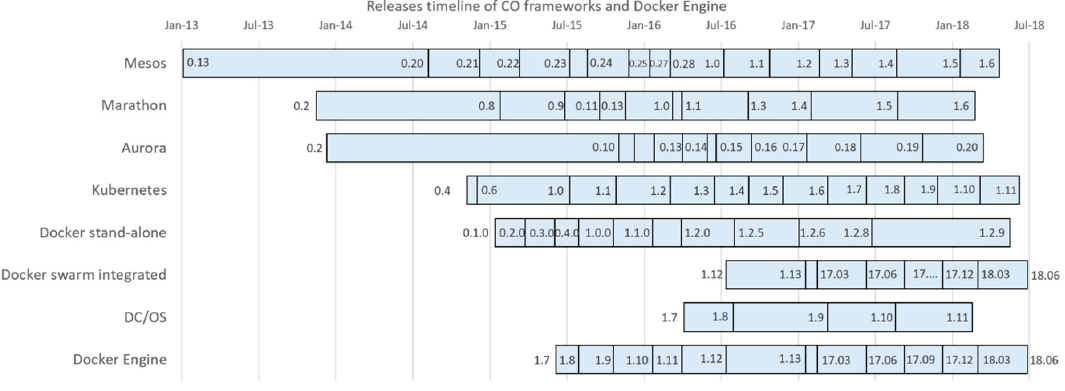
Figure 2. Timeline of when successive versions of container orchestration (CO) frameworks have been released (until September 2018).